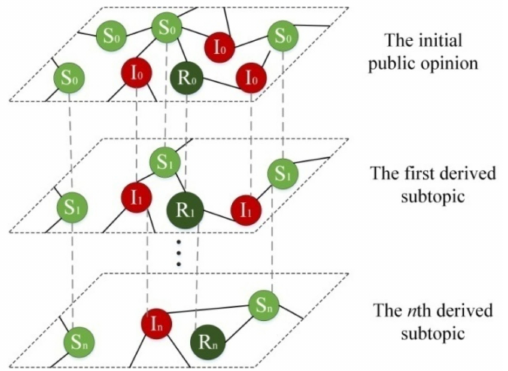
Figure 4. Propagation transformation of derived